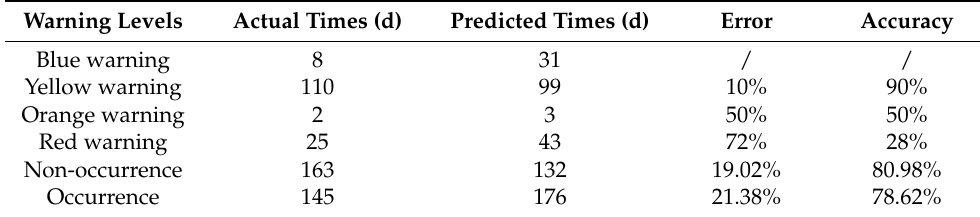
Table 4. The accuracy of the models with point scale with small scale. Warning Levels